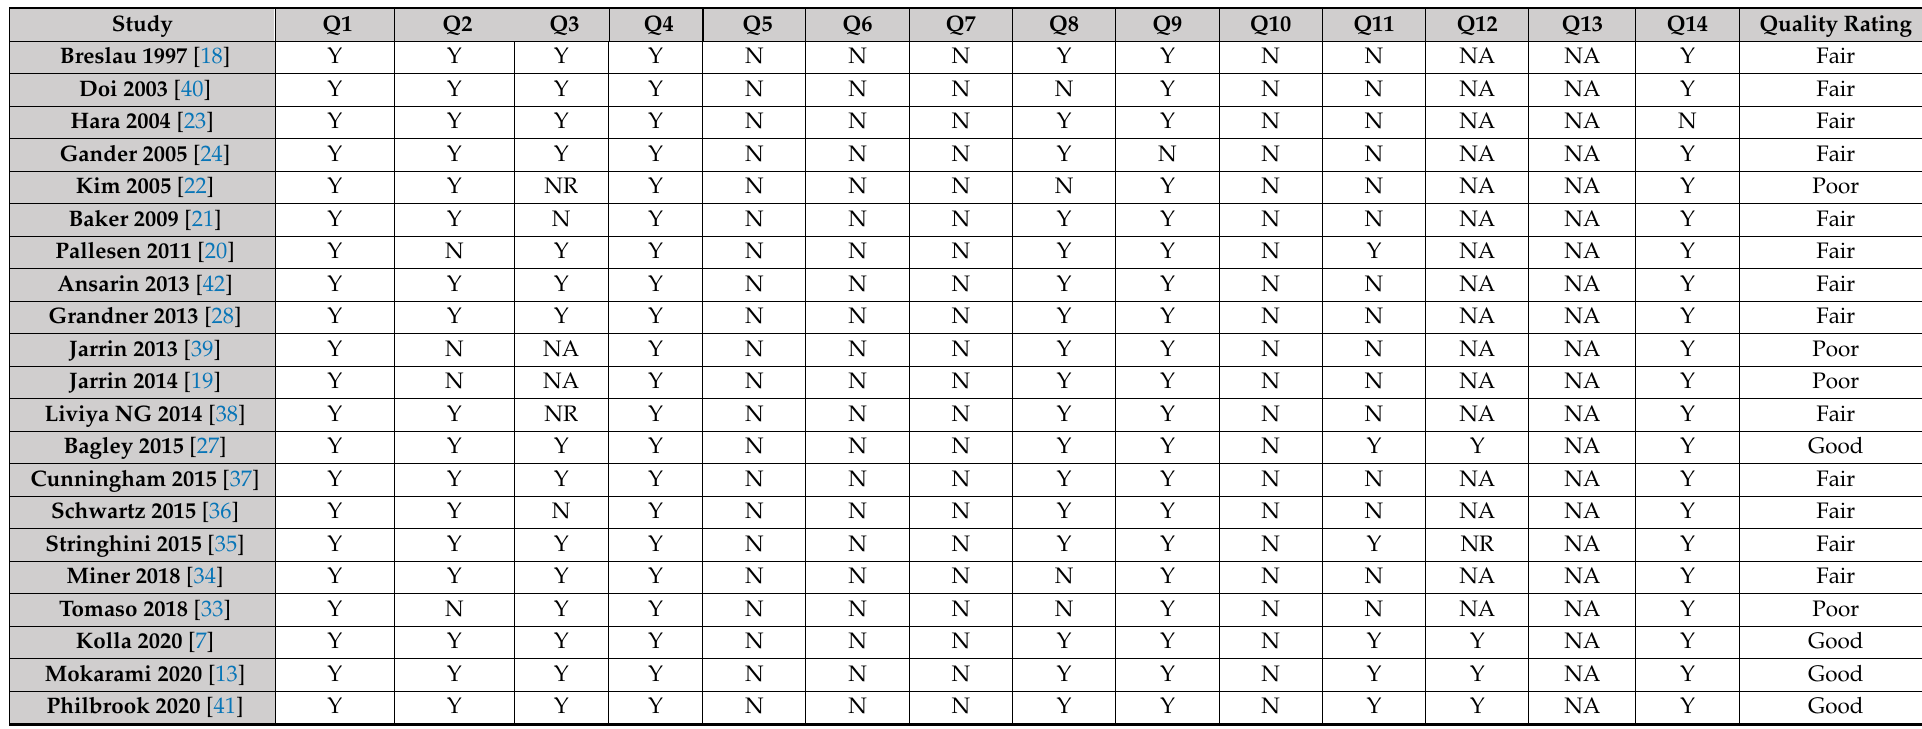
Table 3. Quality rating of included studies using the National Institute of Health’s Quality Assessment Tool for Observational Cohort and Cross-Sectional